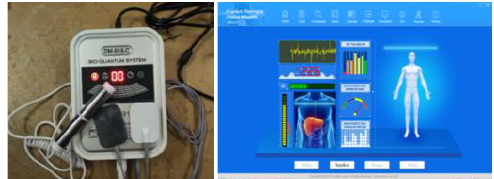
Figure 2. Display tools and screens from QRMA